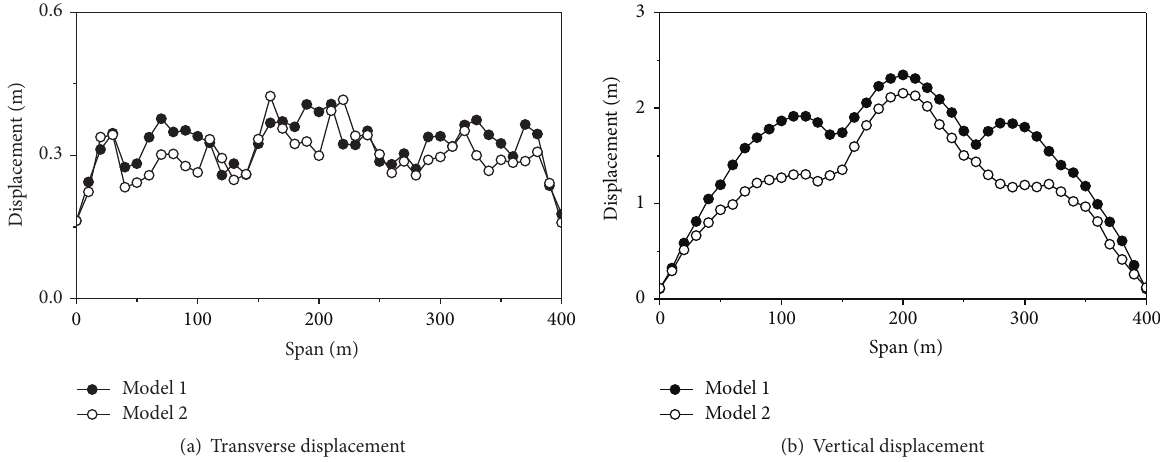
Figure 7: Comparison of the maximum displacements of the transmission lines of the two models of the suspension